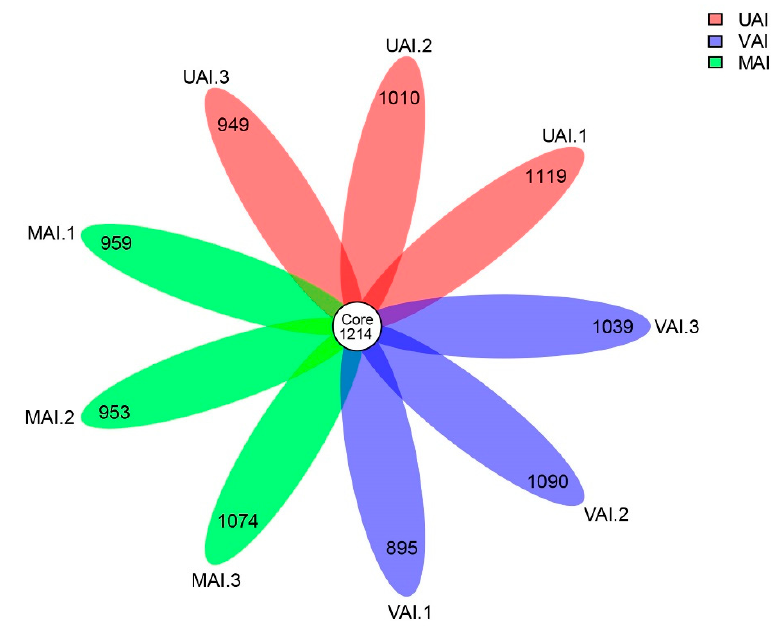
Figure 8. Petal diagram of OTUs distribution in each sample. The numbers in Core represent the number of OTUs shared by the nine samples (i.e., Core OTUs).